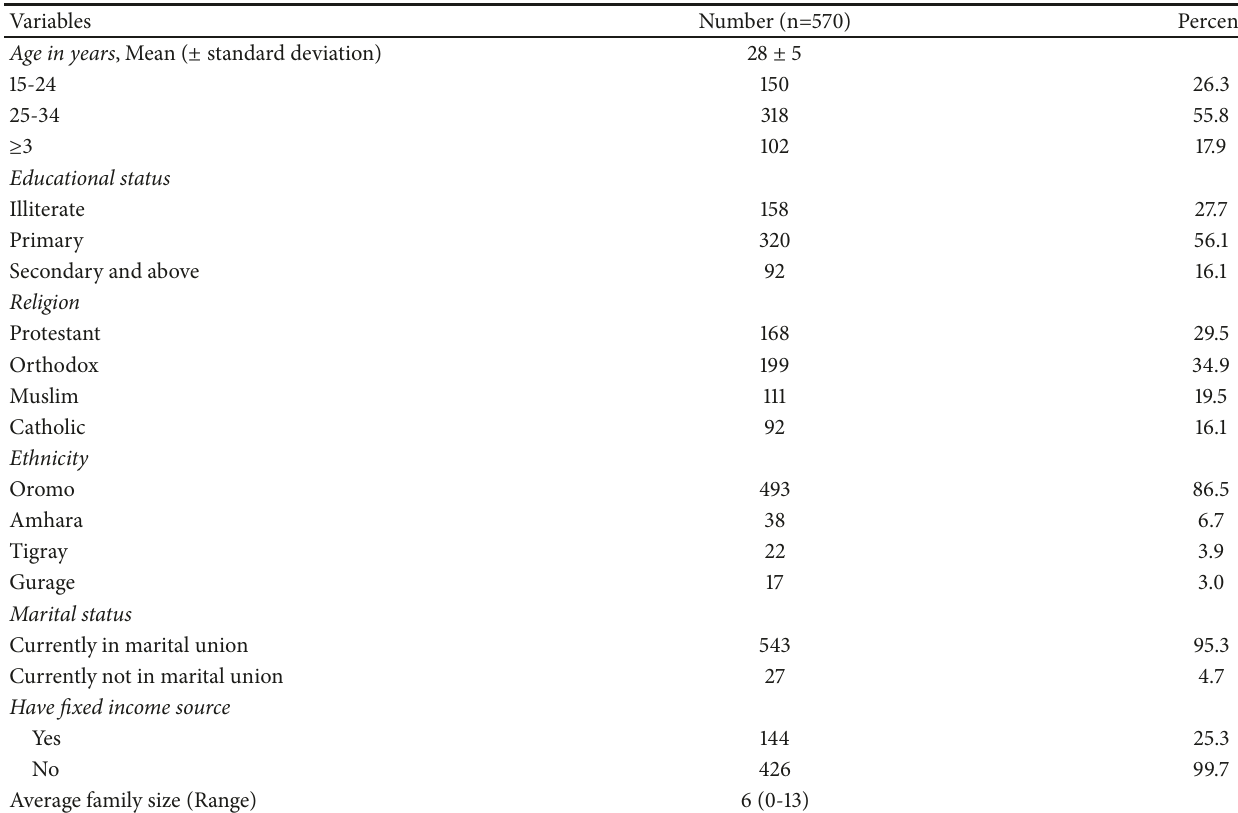
Table 1: Sociodemographic characteristics of study participants’ who gave birth recently, in Jardega Jarte District, Oromia Region, western Ethiopia, from January 1 to February 2,